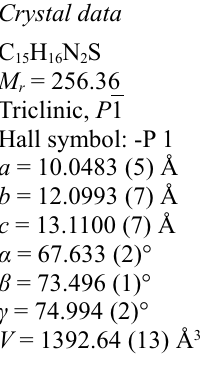
The partial packing figure ( PLATON : Spek, 2003) which shows that intermolecular H-bonds form the ring motifs. 1,3-Bis(3-methylphenyl)thiourea Crystal